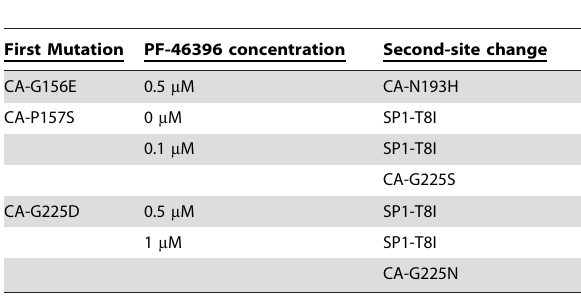
Table 2. Second-site compensatory changes for PF-46396- dependent CA